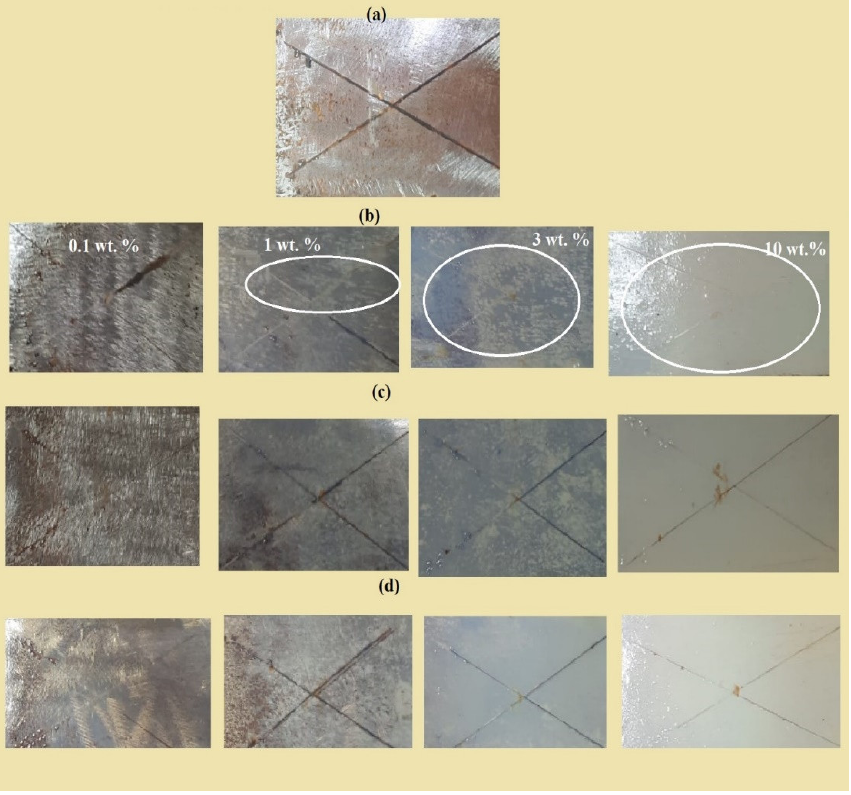
Figure 15. Salt spray resistance of the cured DGEB/ PA in the presence of different weight % of ( a ) blank, ( b ) EOA-TiO 2 , ( c ) ELOA-TiO 2 and ( d ) ELNA-TiO 2 NPs. blank, ( b ) EOA-TiO 2 , ( c ) ELOA-TiO 2 and ( d ) ELNA-TiO 2